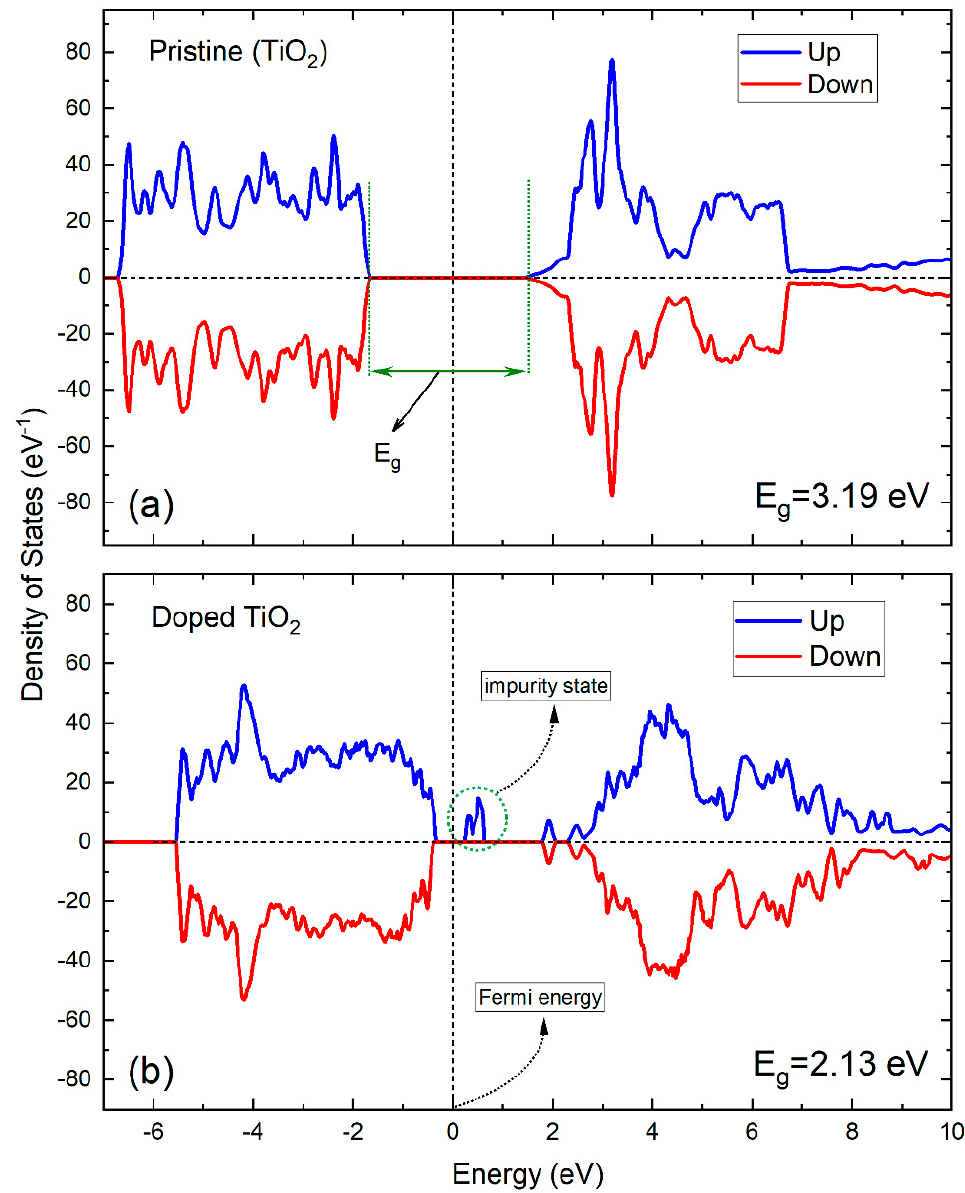
Figure 6. Density of states for ( a ) pristine TiO 2 and ( b ) Ce–Sm co-doped TiO 2 nanomaterials.